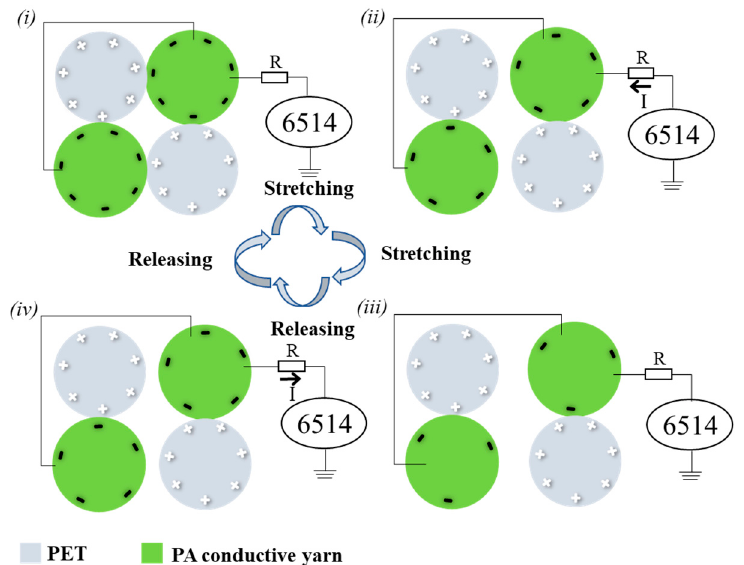
Figure 3. The working mechanism of the 3DWE-TENG with a stitching double weave, ( i ) In the original state without stretch; ( ii ) The 3DWE-TENG is gradually stretched; ( iii ) The 3DWE-TENG is stretched to the largest deformation; ( iv ) The 3DWE-TENG is recovering to the original state.